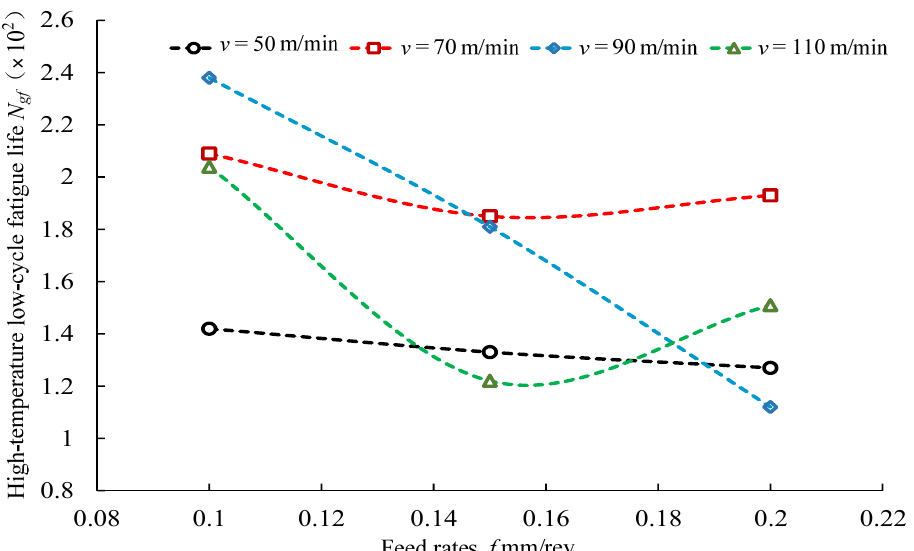
Figure 15. Effects of feed rates on high-temperature low-cycle fatigue life. To further optimize the turning process parameters, the regression relationship model between the high-temperature low-cycle fatigue life of the superalloy Inconel 718 and turning process parameters are shown in Equation (10).